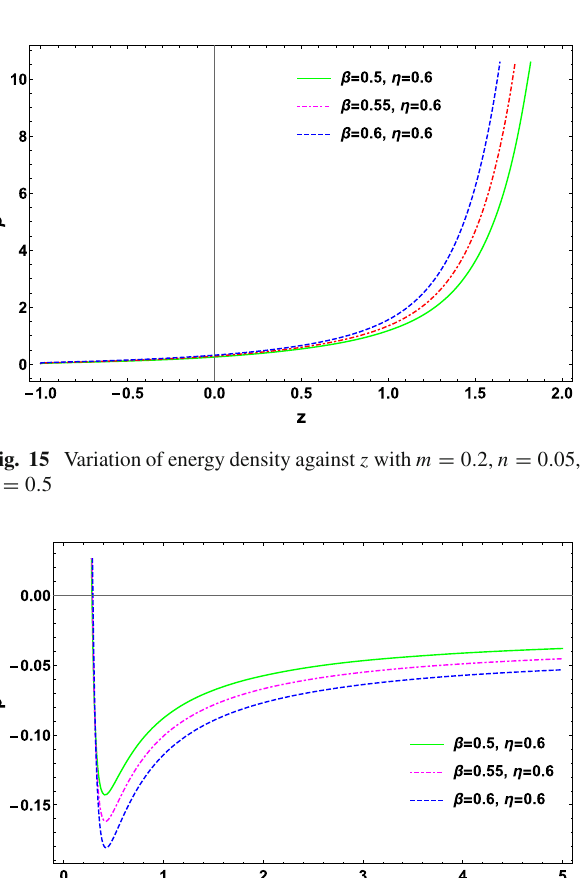
Fig. 14 Variation of energy density against time with m = 0 . 2, n = 0 . 05, λ = 0 . 5